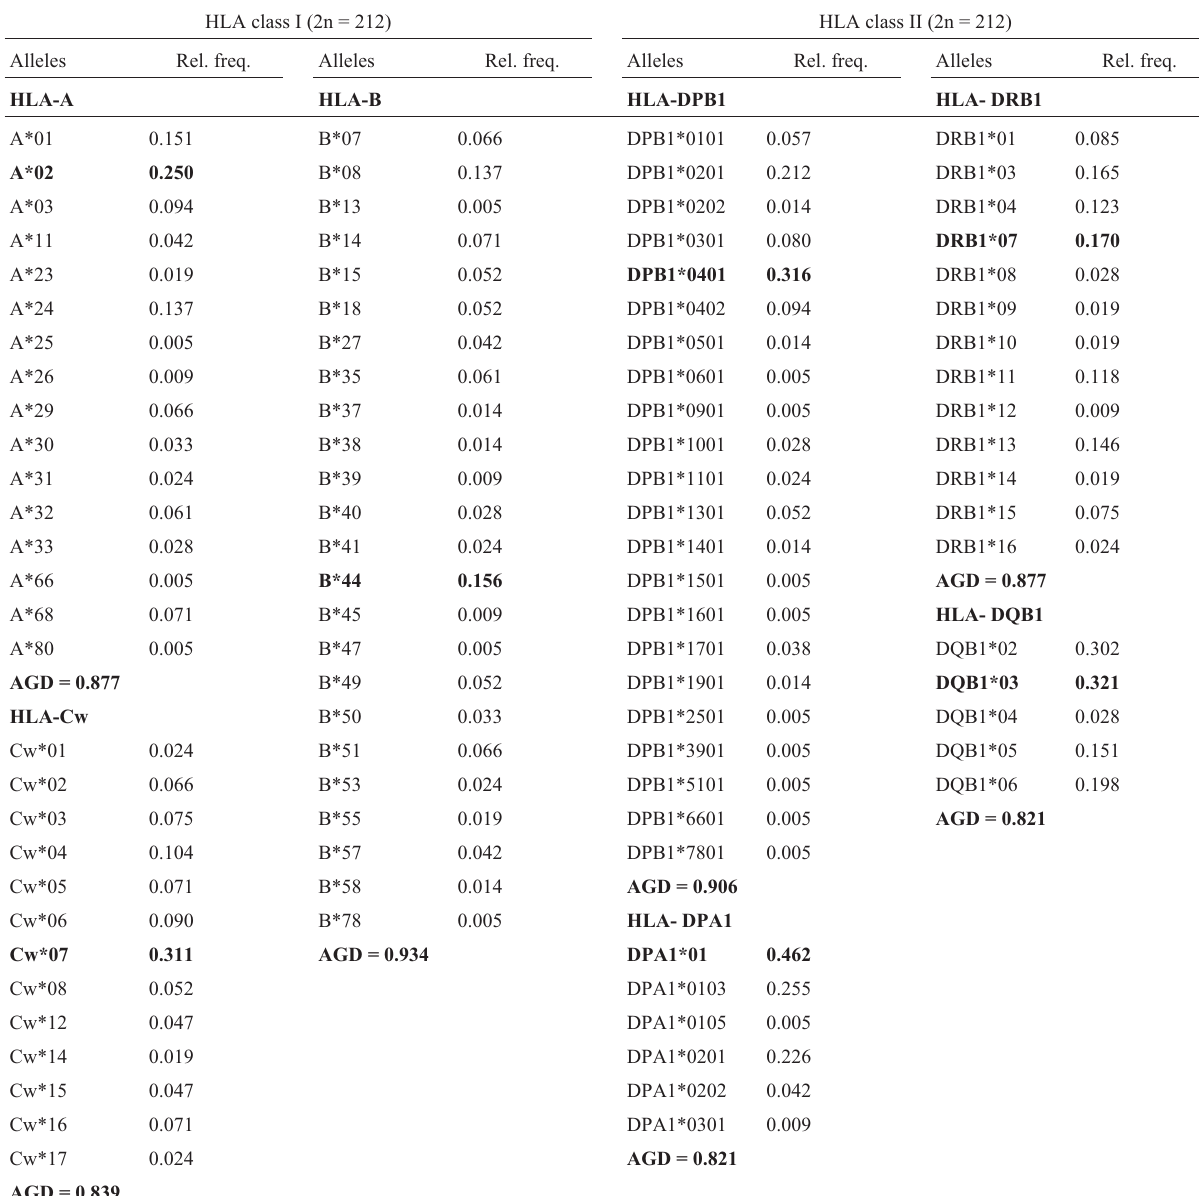
Table 1 - HLA class I and II allele frequencies and average gene diversity (AGD) in the São Miguel population (the highest values are in bold type). HLA class I (2n = 212)